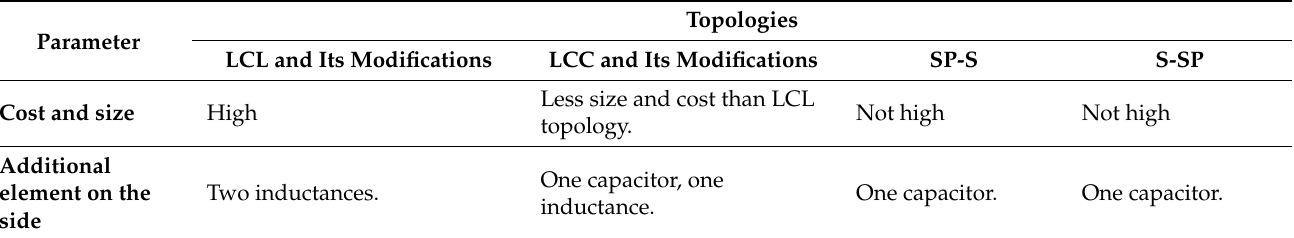
Table 5. Comparison of hybrid topologies [128,131,149,163,168,175,176,180,181]. Topologies Parameter LCL and Its Modifications LCC and Its Modifications SP-S S-SP Less size and cost than LCL Cost and size High Not high Not high topology. One capacitor, one Two inductances. One capacitor. One inductance.